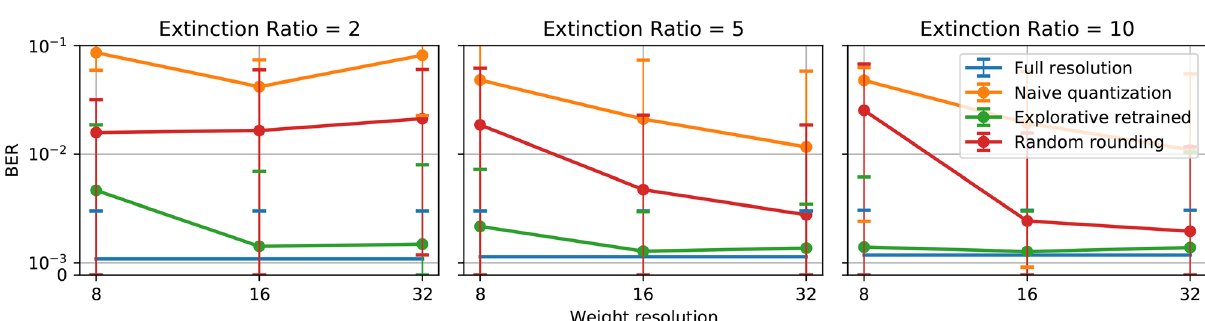
Figure 4. Performance comparison of three different extinction ratio, 2 (left), 5 (middle), 10 (right) for the 4-bit header recognition task over different resolutions. The blue curve represents the performance of full-resolution weights; the orange curve represents ‘naive’ quantization weights; the green curve for explorative retrained quantization